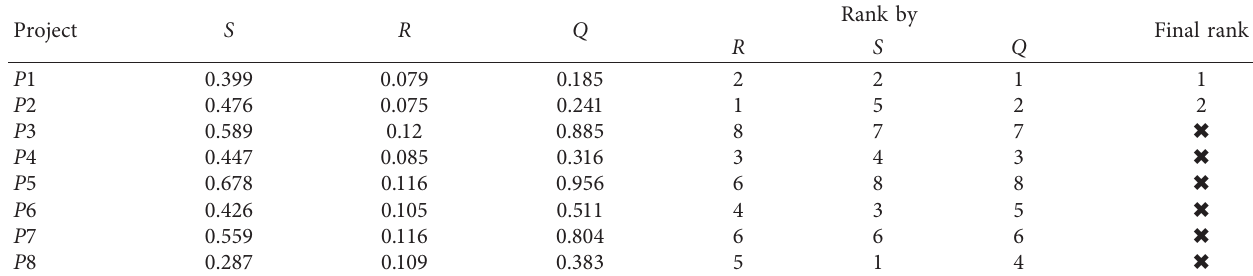
Table 33: Project ranking in deterministic condition.